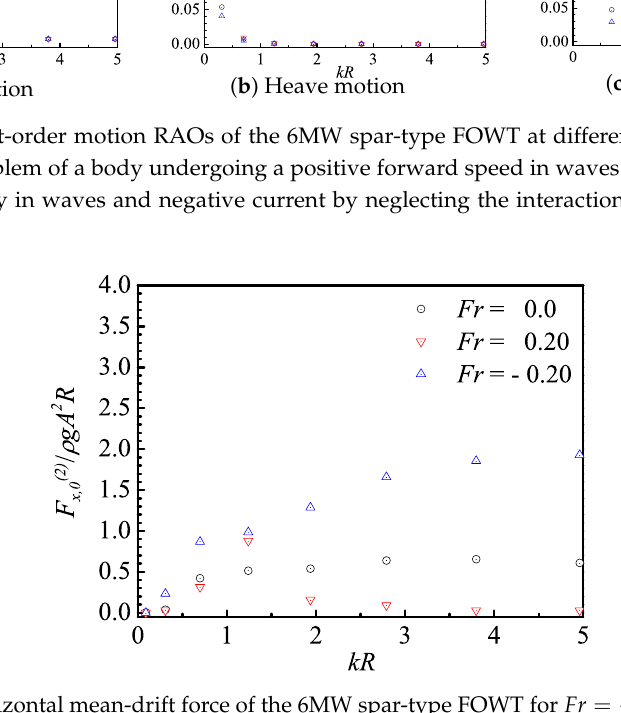
Figure 18. Horizontal mean-drift force of the 6MW spar-type FOWT for Fr = − 0.2, 0.0 and